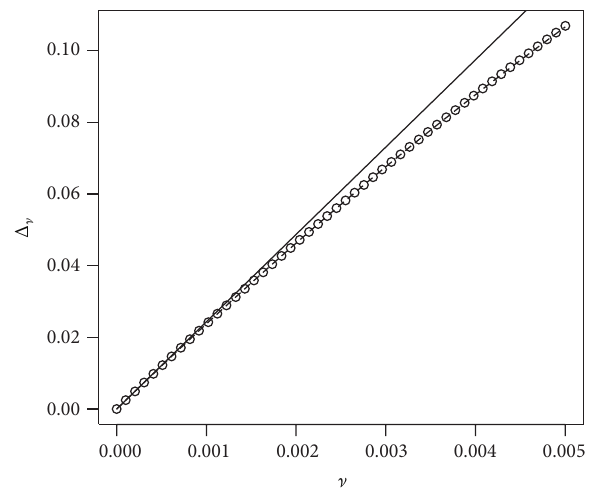
Figure 11: The plot shows Δ ] as a function of ] (dots) with the first-order (solid line) and the second-order (dashed line) Taylor expansionssuperimposed.Parametersare 𝑟 = 4 %, 𝜇 = 8 %, 𝜎 = 20 %, 𝛾 = 10 %, 𝛼 = 50 %, and 𝑡 = 40